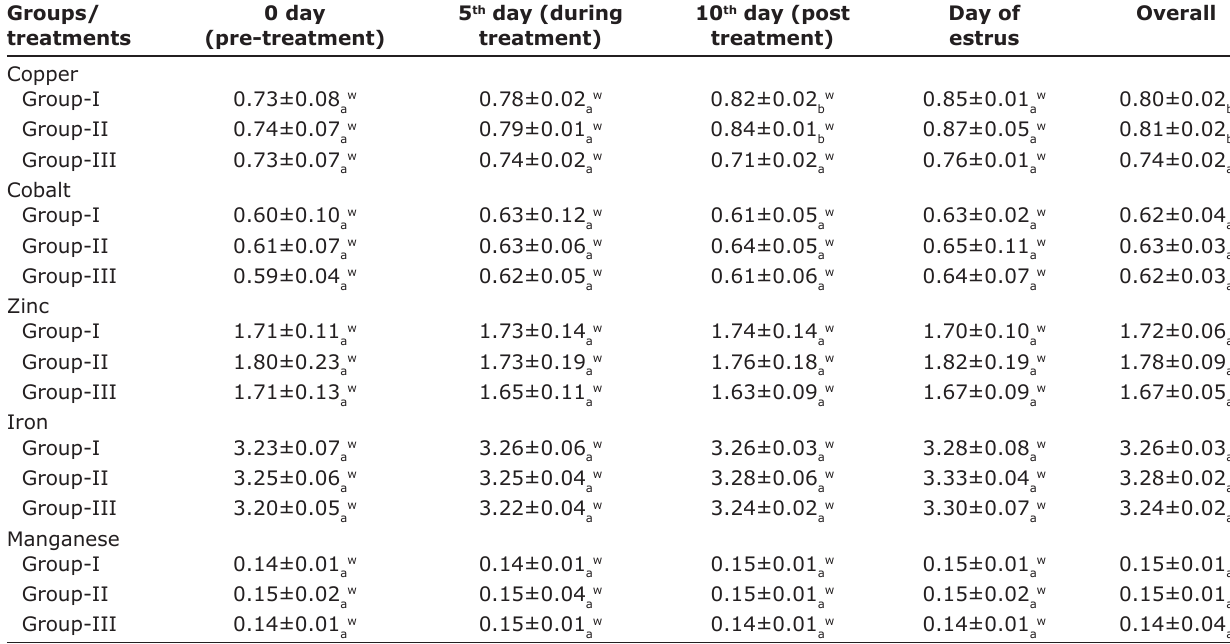
Table-2: Serum copper, cobalt, zinc, iron, and manganese levels (µg/ml) at different time intervals/days in anestrous treated and control groups of buffaloes (mean±SEM). Groups/